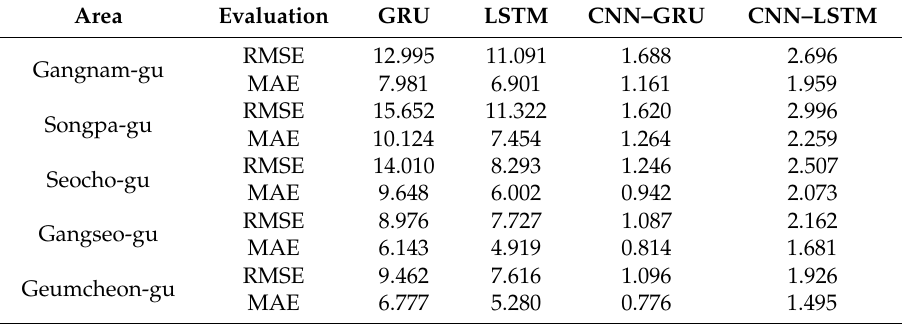
Table 8. Seven-day predictions of PM 10 levels in five areas.